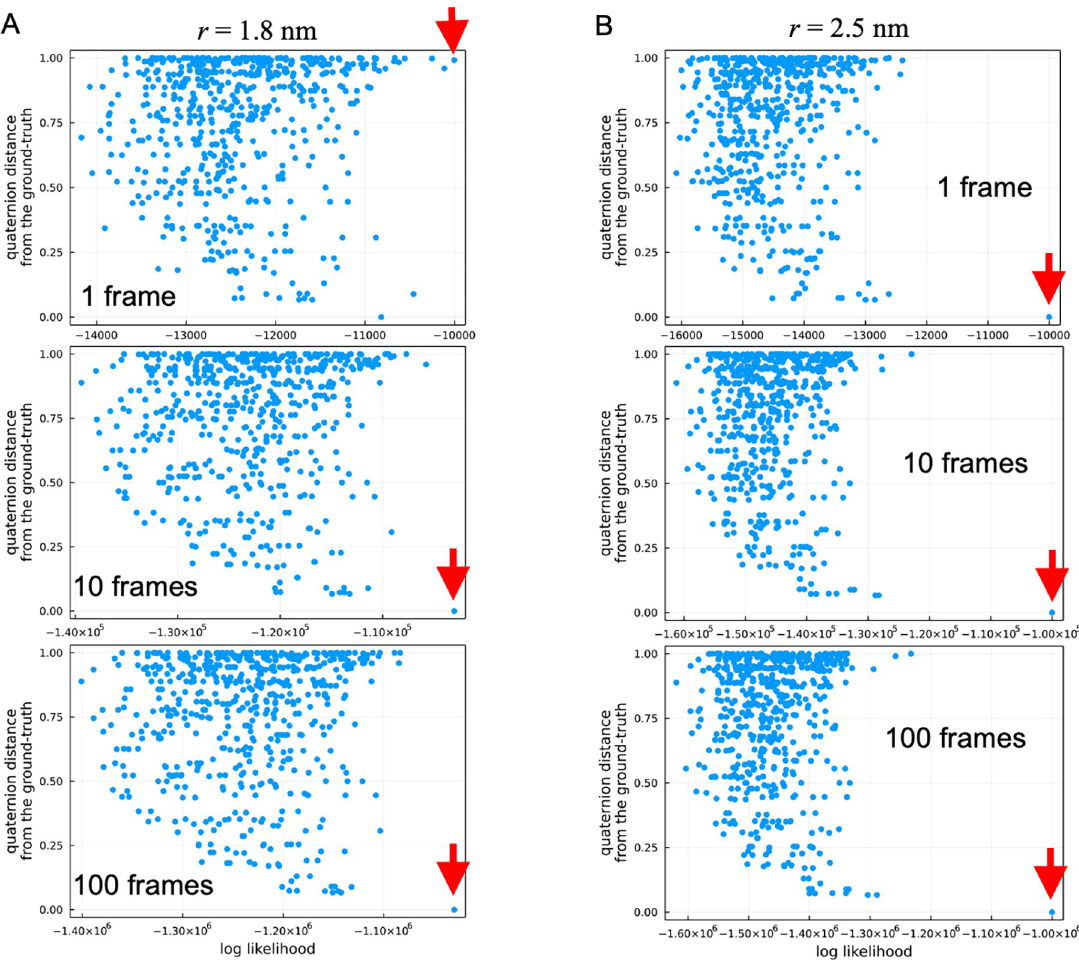
Fig 5. Maximum likelihood of pseudo-AFM time-series images in each orientation computed using the first single frame, the first 10 frames, the first 100 frames of the first set AFM data (defined by Eq 3). Note that only the maximum likelihood for each orientation is shown due to computational costs (calculated by the Viterbi algorithm). The maximum likelihoods among all orientations are indicated by red arrows. (A) Likelihoods computed with the tip apex radius of 1.8 nm. (B) 2.5 nm (the